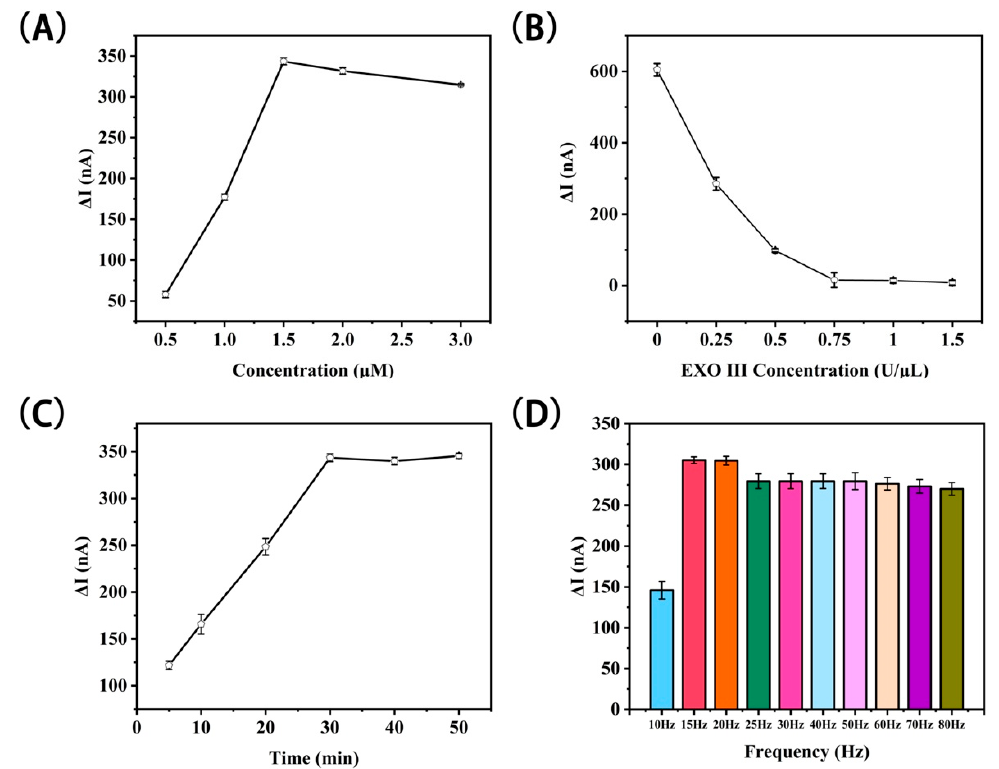
Figure 5. Optimization of the electrochemical DNA sensor based on terminal protection. The effect of ( A ) modified electrode DNA concentration, ( B ) EXO III concentration, ( C ) incubation time of the modified electrode in SA, ( D ) frequency of the electrochemical DNA sensors. Error bars represent the standard deviation of the measurement (n = 3).